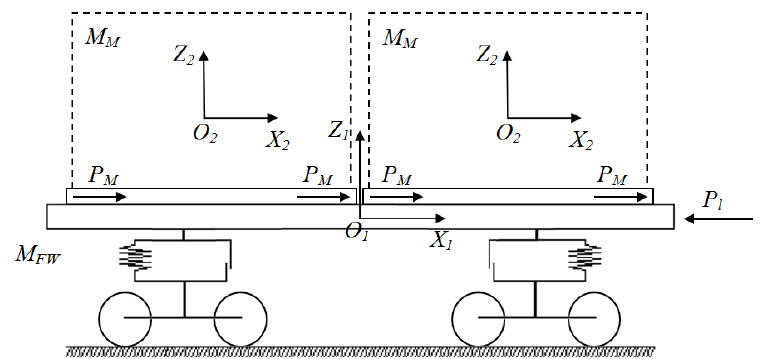
Figure 8. Design diagram of a flat wagon loaded with two removable modules.